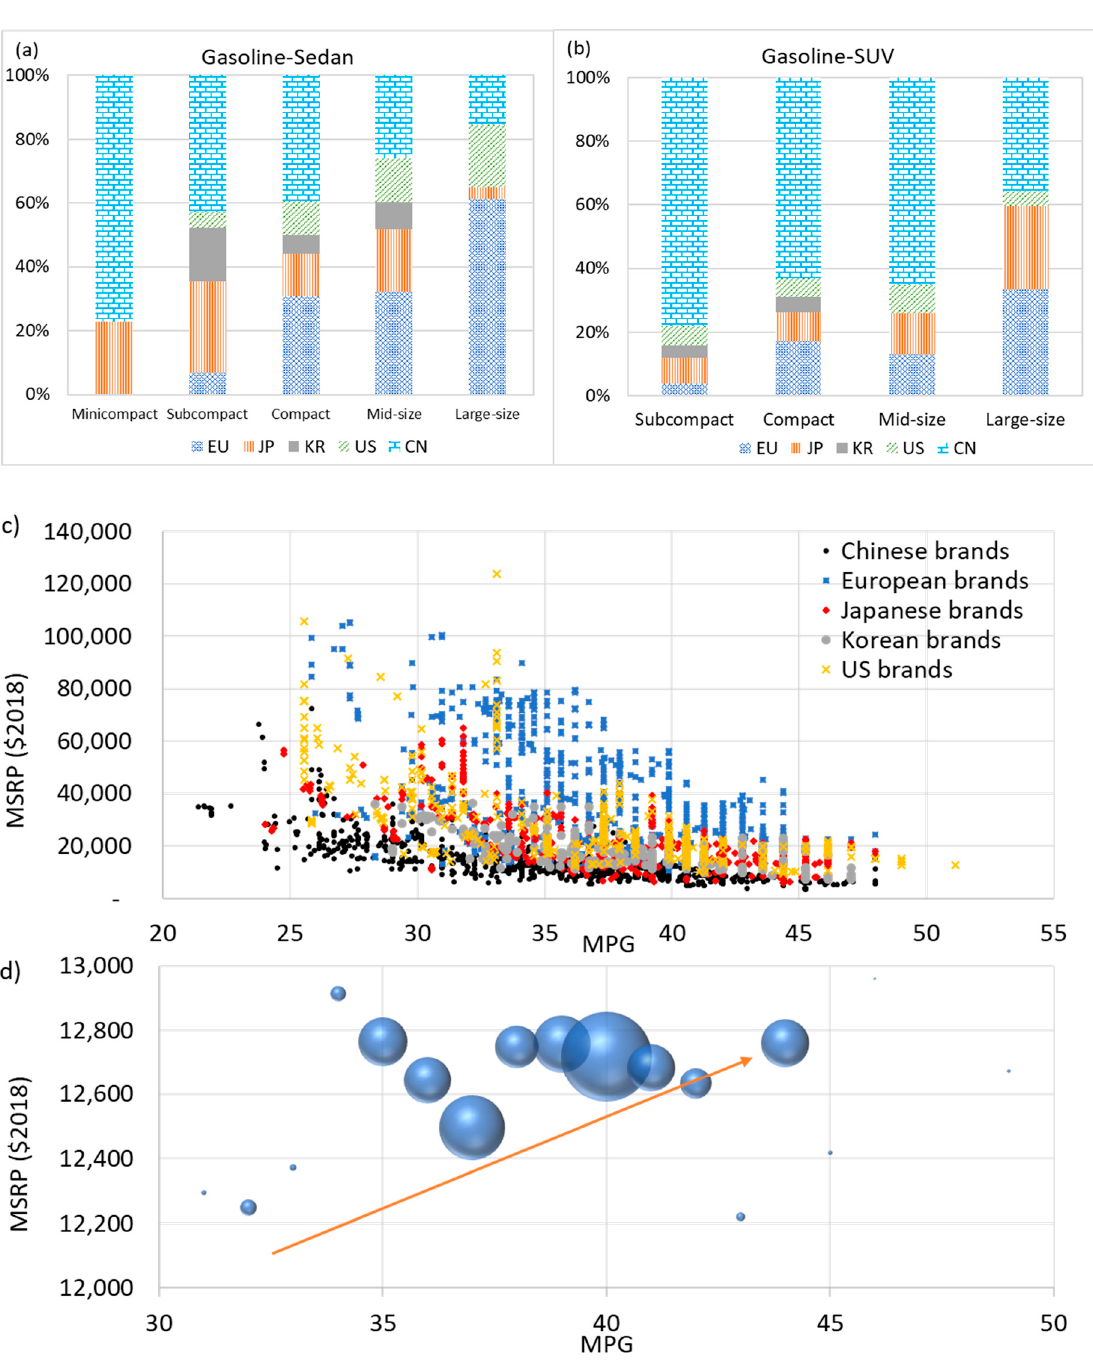
Figure 11. ( a ) Share of sedan models by vehicle size and by brand origin; ( b ) share of SUV models by vehicle size and by brand; ( c ) the relationship between MSRP and MPG by brand origin; and ( d ) relationship trend of MSRP and MPG in sedans ranging from $12,000 to $13,000 (bubble size indicates the